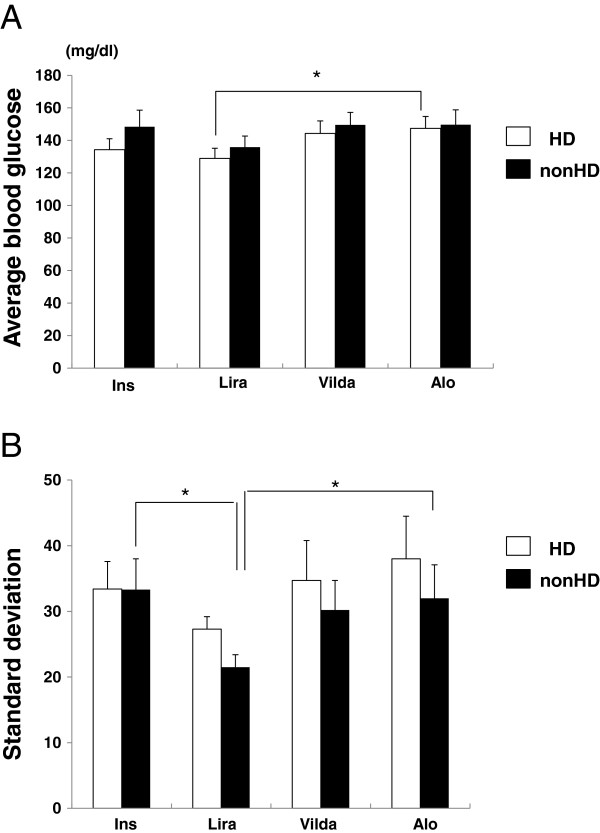
Average glucose level (A) and standard deviation (B). Data are presented as mean ± SEM, *p < 0.05, n = 10, Ins; insulin, Lira; once-daily injection of 0.3 mg liraglutide, Vilda; once-daily oral administration of 50 mg vildagliptin, Alo; once-daily oral administration of 6.25 mg alogliptin.